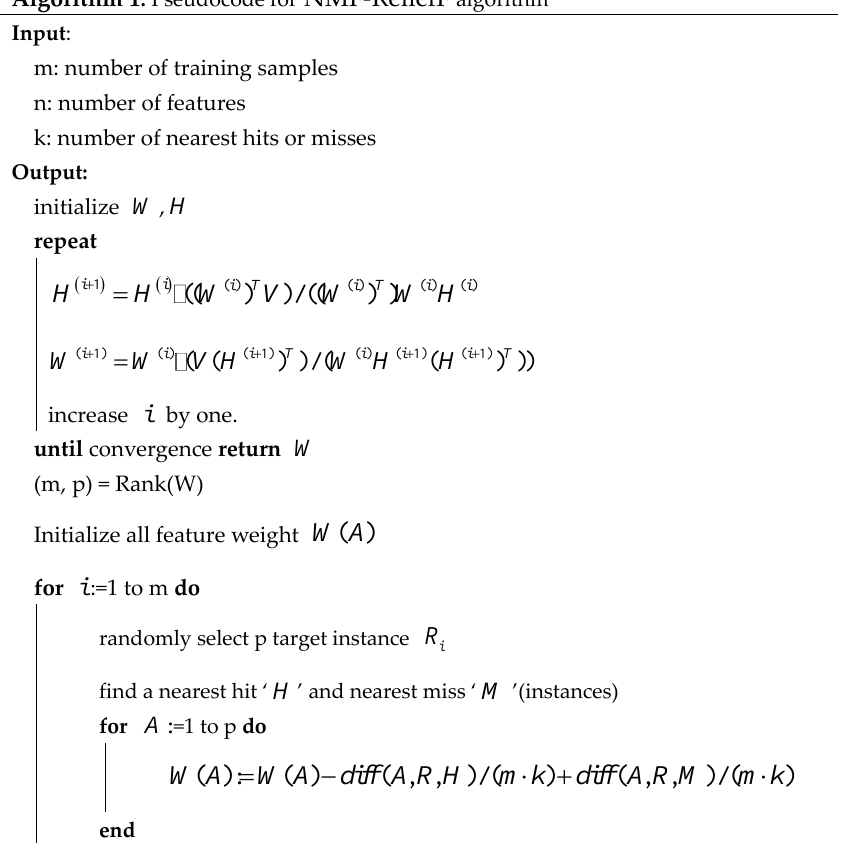
Algorithm 1 . Pseudocode for NMF-ReliefF